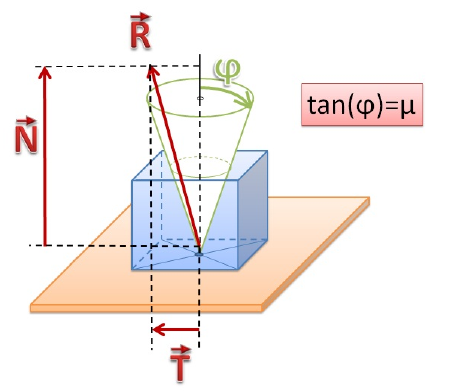
Figure 5. Open dynamics engine’s friction cone